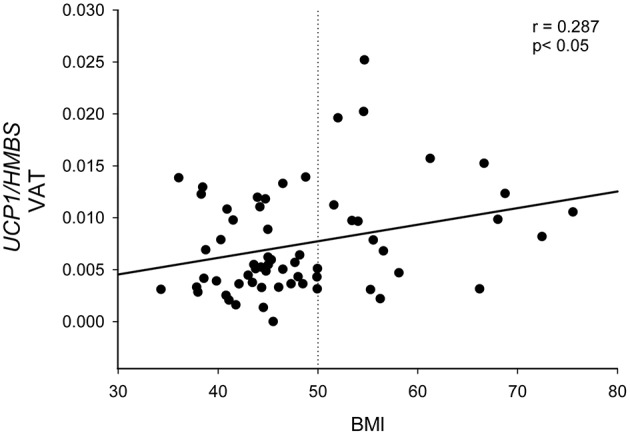
Correlation between UCP1 expression in visceral omental adipose tissue and BMI. UCP1 mRNA expression quantified by qPCR and normalized to HMBS mRNA was correlated with BMI in 61 patients with severe obesity. Statistical analysis was performed by Pearson correlation. The dotted line represents the BMI cut-off of 50 kg/m2 used to divide patients in Figure 4.